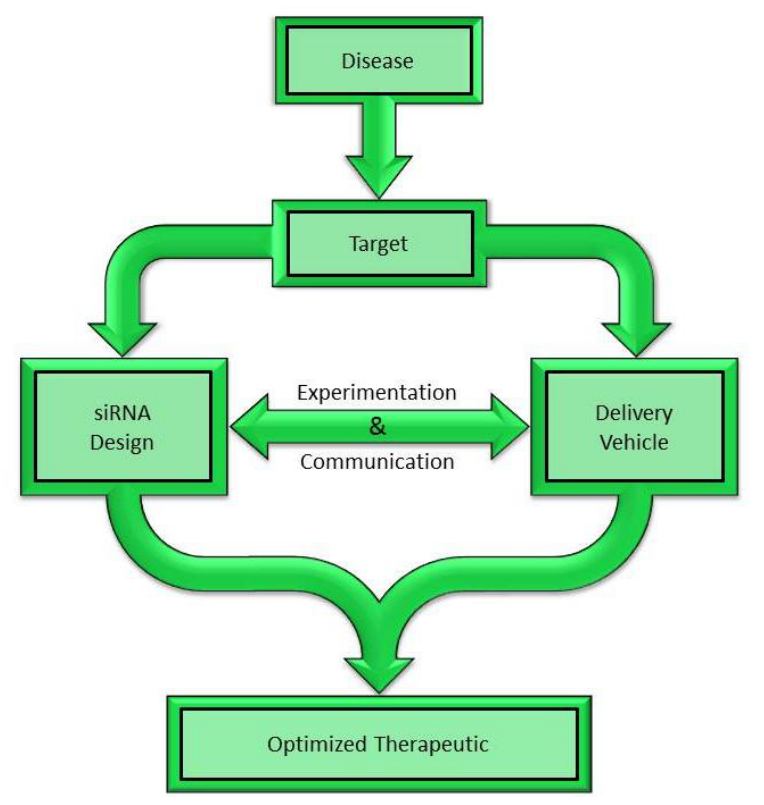
Figure 1. siRNA design overview. siRNA therapeutic design should, in the short